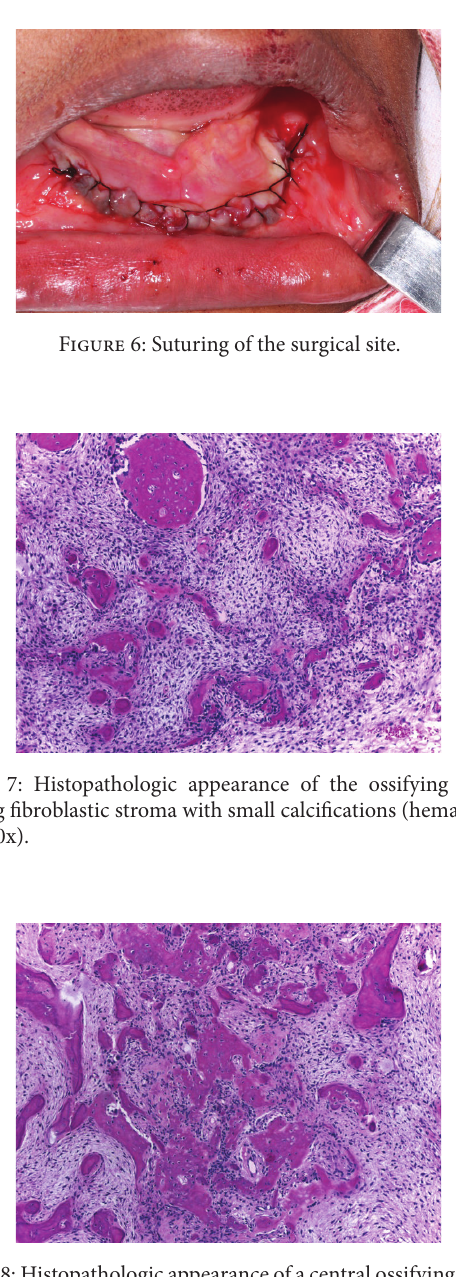
Figure 8: Histopathologic appearance of a central ossifying fibroma shows spherules of cementoid material in a highly cellular fibrous connective tissue stroma (hematoxylin-eosin, 10x).